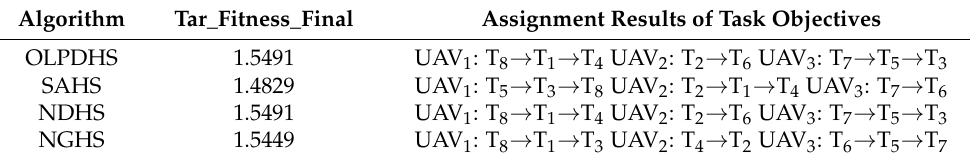
Figure 8. The convergence curves of fitness of two algorithms. Table 8. Assignment results of task objectives corresponding to optimal fitness. Algorithm